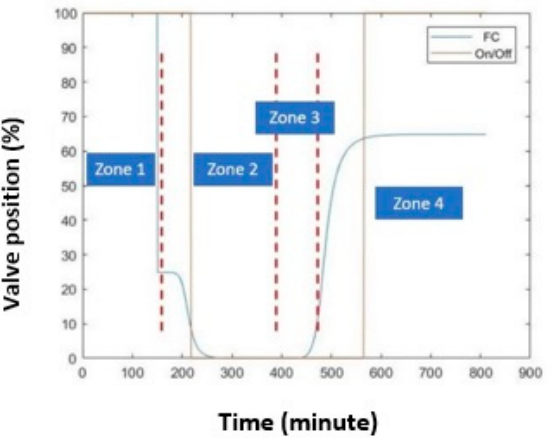
Figure 15. Valve position variations ϑ P ( t ) regarding the FC and On/Off controller during the experiment in an office room with a small size. Zone: It remarks different conditions during the experiments.